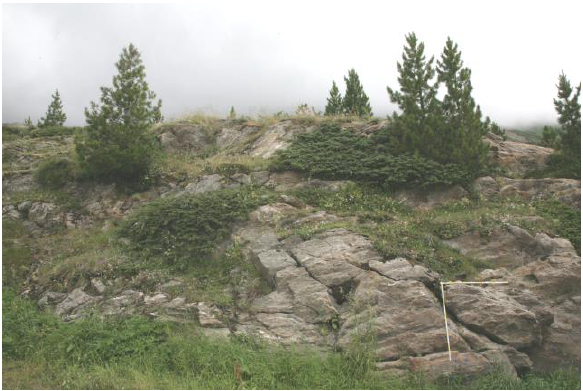
Figure 1. Rocky slope with vegetation and wooden scale bar